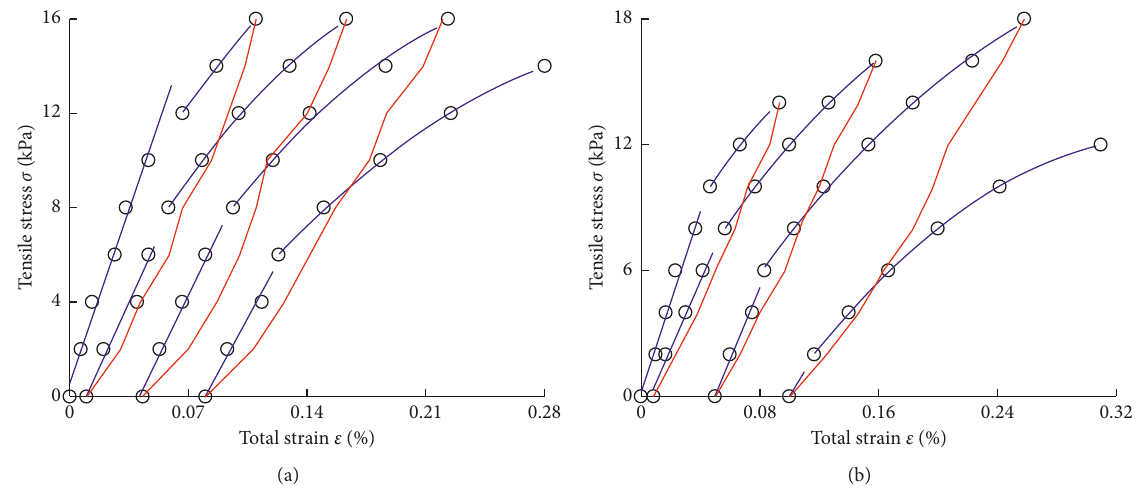
Figure 16: Function fitting of the stress-strain curves for (a) loading pattern I and (b) loading pattern II. Table 6: Model parameters from the best-fitting stress-strain curves. Loading curves